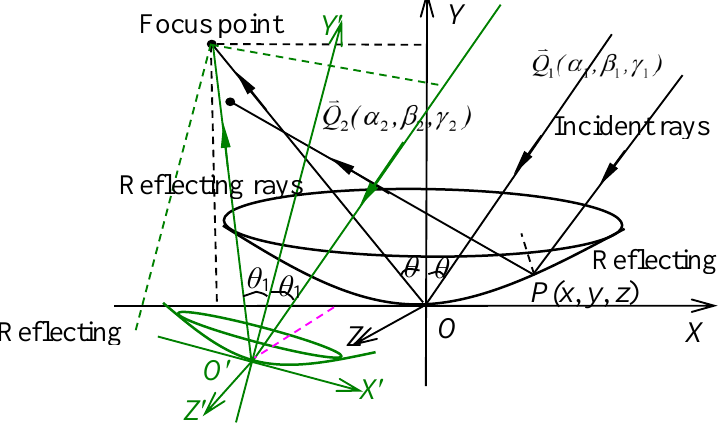
Figure 4. The aspheric reflector whose vertex is not at point O.